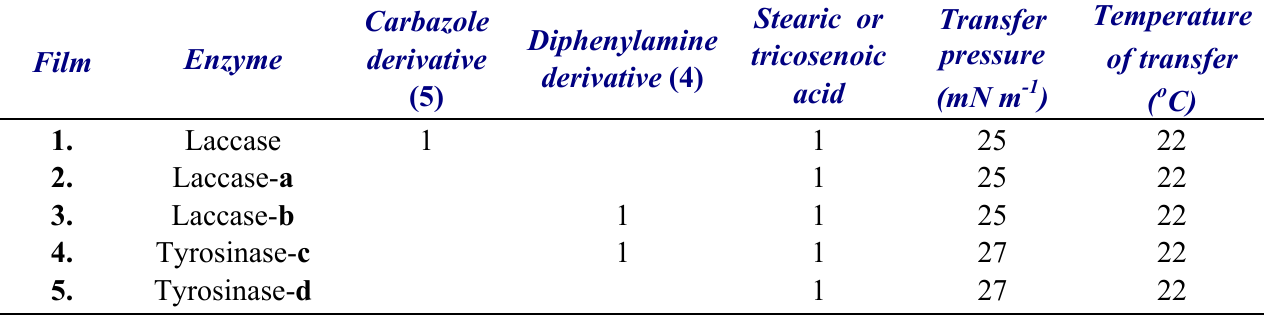
Table 3. Compositions of Langmuir-Blodgett films and their transfer conditions